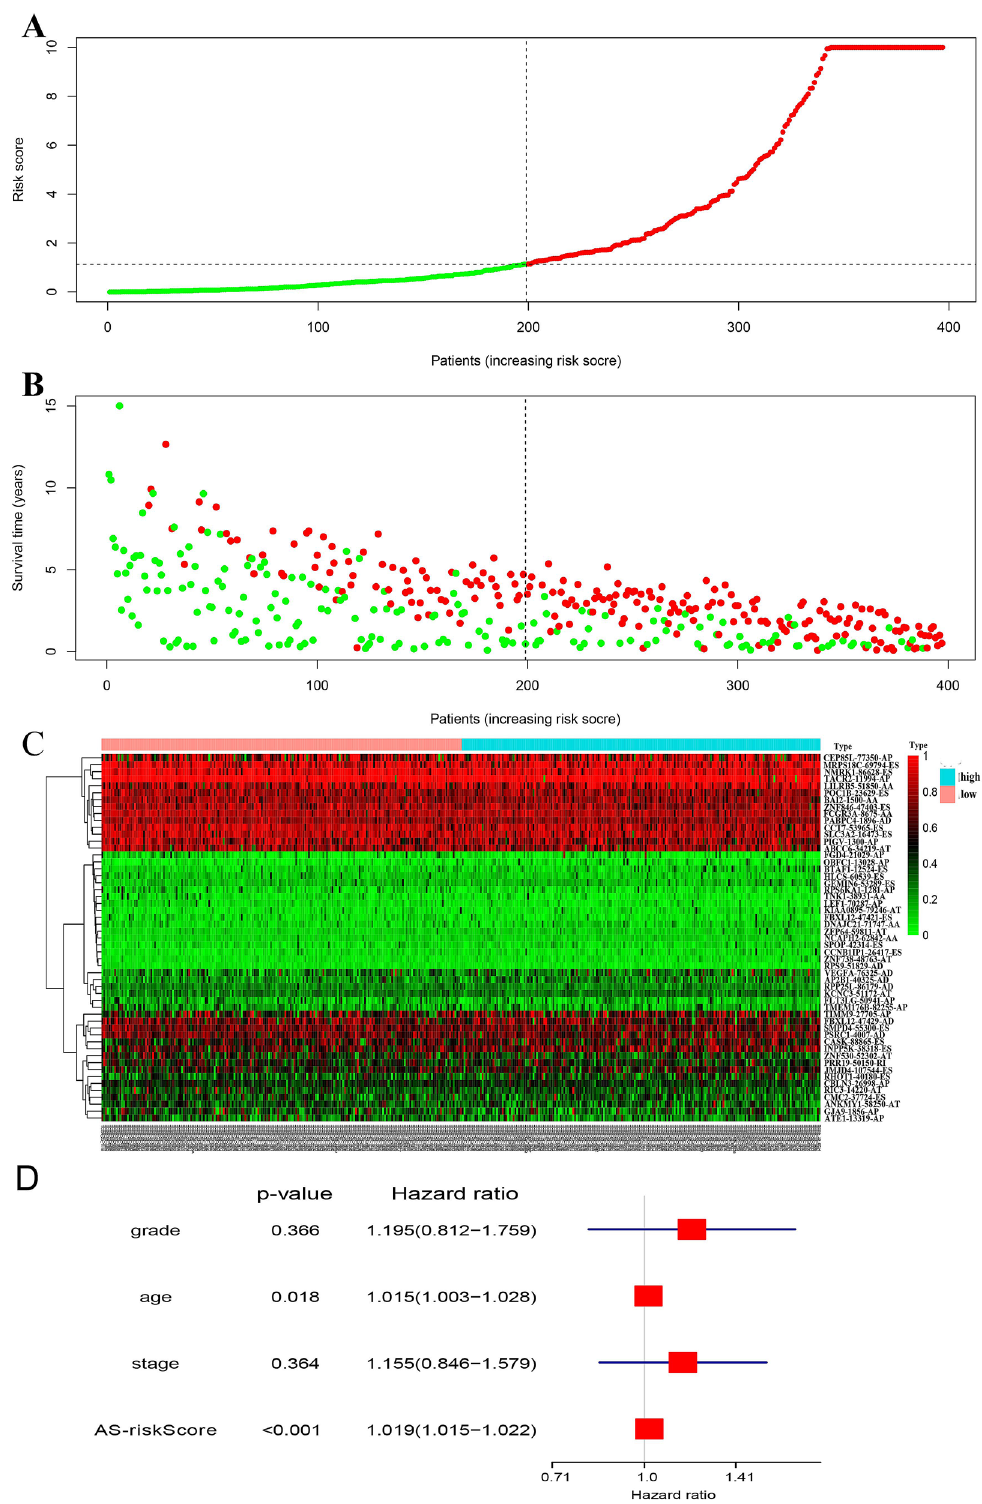
Figure 5. The recognition capability of prognostic signature for dividing patients into low- and high-risk groups in ovarian carcinoma. ( A ) The risk values based on AS in low-risk (green dots) and high-risk (red dots) patients. ( B ) Survival time for ovarian carcinoma patients. The left and right respectively showing low-risk and high-risk patients. Green dots indicating survival patients and red dots indicating dead patients. ( C ) The PSI values of final prognostic signature in ovarian patents. ( D ) The independent prognostic indicator for AS